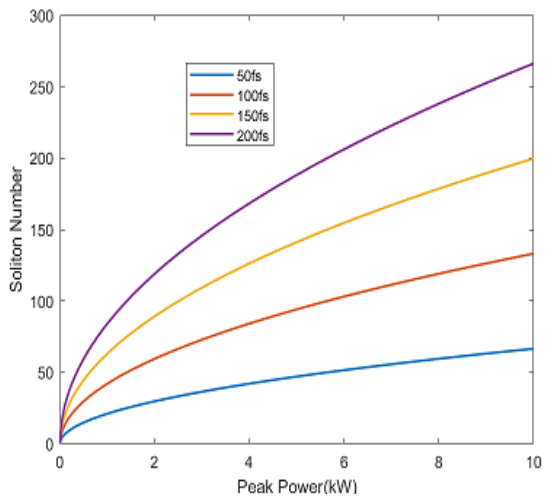
Figure 7: Number of solitons generated at different input pulses